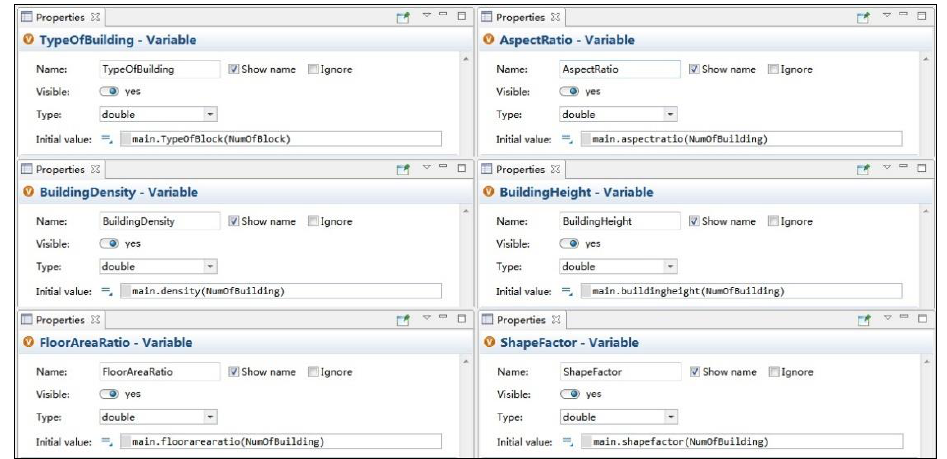
Figure 3. The setting of the command for the assignment of urban morphology variables. The initial value of urban morphology parameters is the current state of each block.